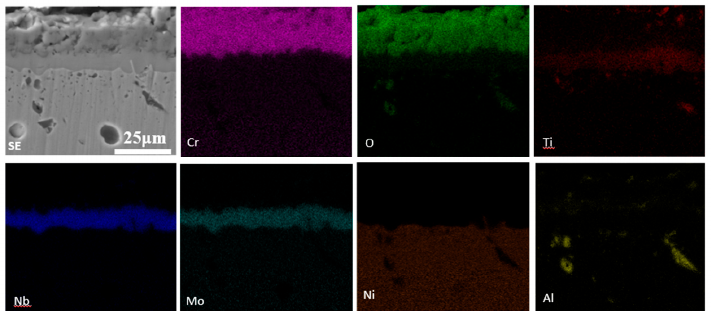
Figure 13. Elemental distribution maps of cross-sectional surface of 55 ° specimens after oxidation at 1000 °C for 100 h under secondary electrons (SE) mode.